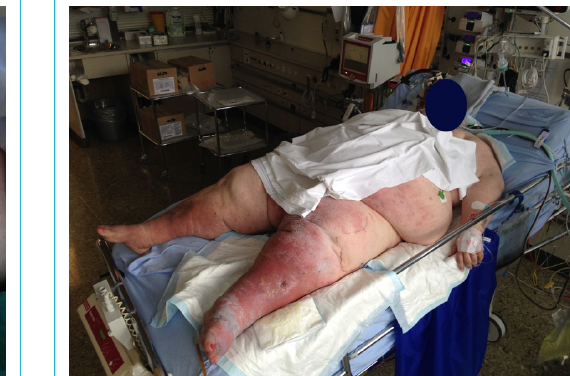
Figure 2: Applying venovenous extracorporeal membrane oxy- genation for CO 2 removal as an alternative to mechanical ventila- tion. The patient gave her informed consent to this publication in- cluding anonymous pictures of